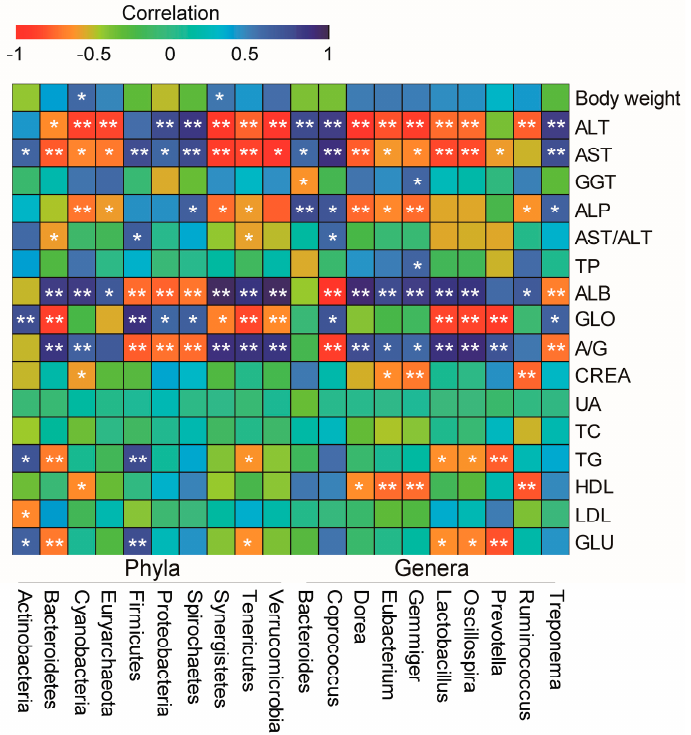
Figure 6. Heatmap diagram representing the correlation between the top 10 abundance of microbi- ota and phenotypes. * p < 0.05, ** p < 0.01. and phenotypes. * p < 0.05, ** p <